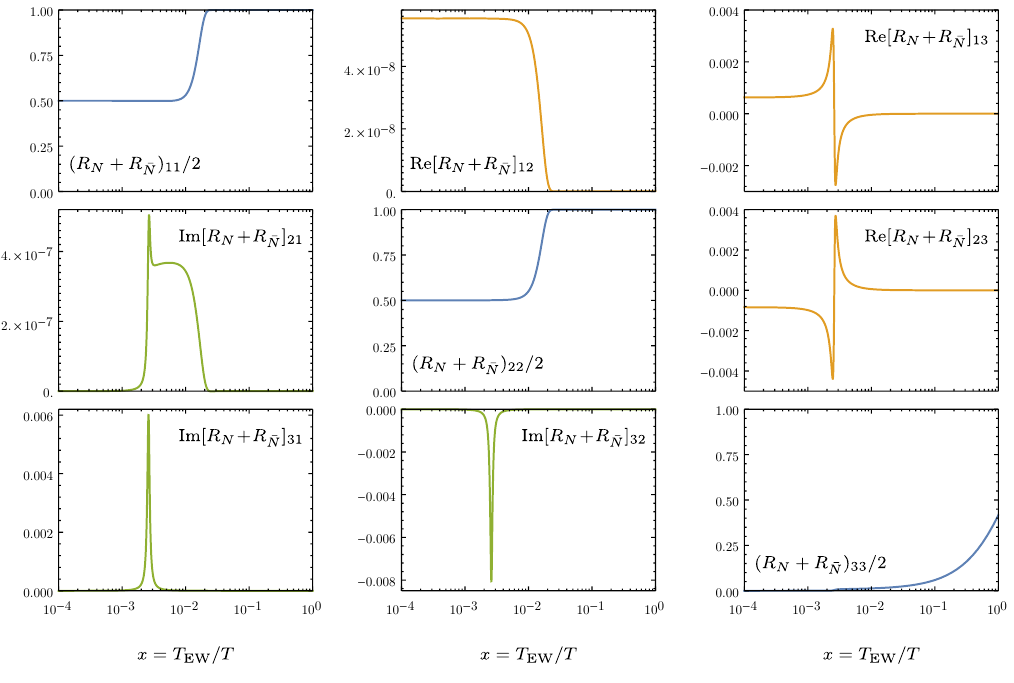
Figure 7 . Entries of the density matrix for benchmark point